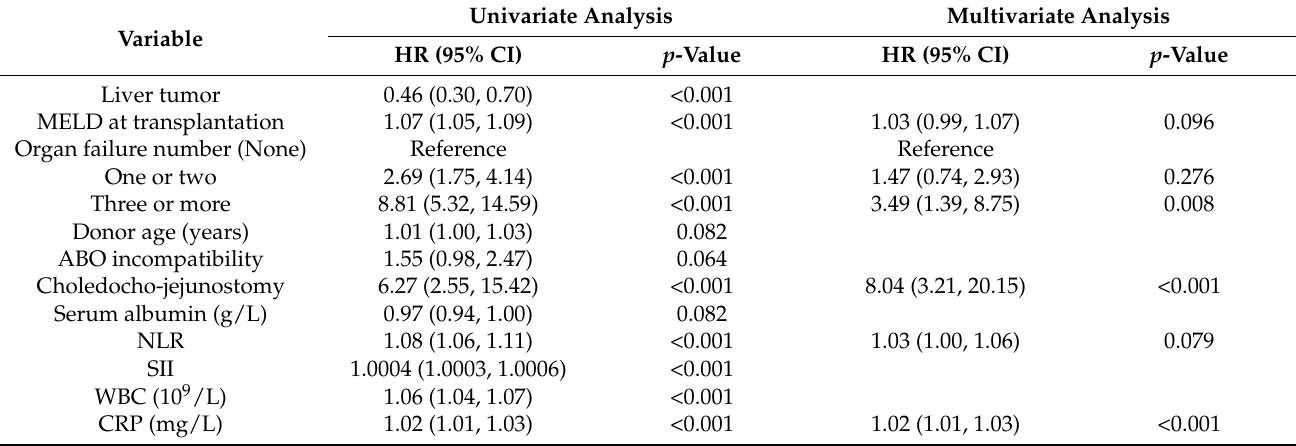
Table 4. Univariate and multivariate analysis of risk factors for 30-day CSI in exploratory